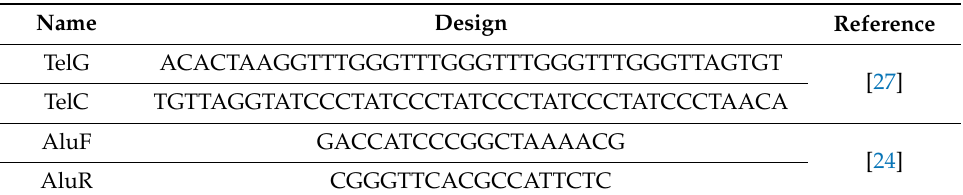
Table 1. Primer design for amplification of the telomere and the multicopy reference gene for quantitative real-time polymerase chain reaction (qRT-PCR) analysis of the relative telomere length in polar bodies and